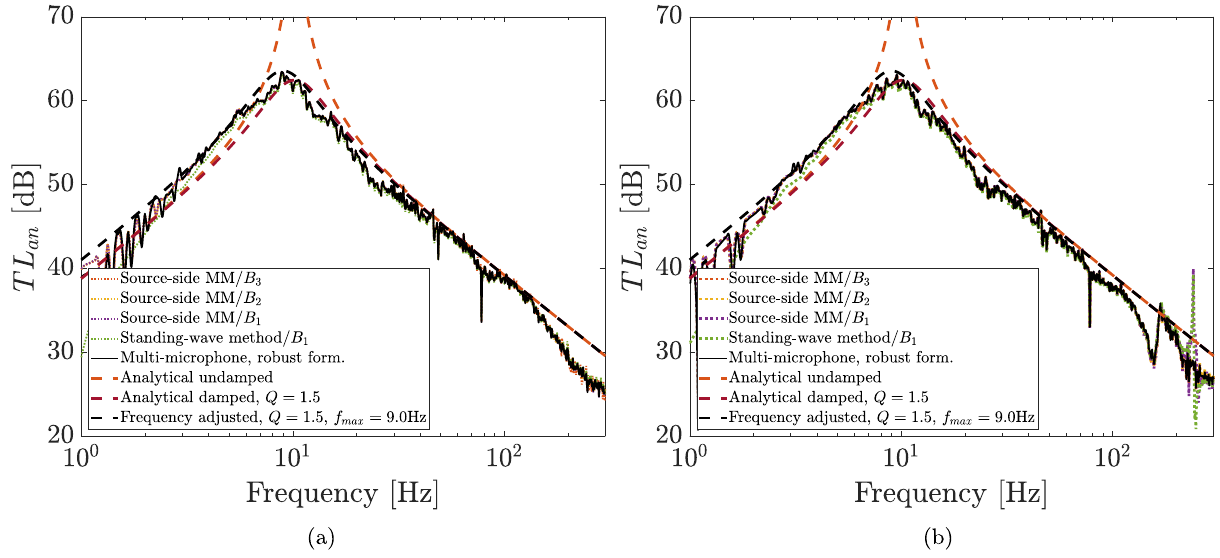
Figure 10. Comparison between measured TL an of the gas resonator with p 0 = 3.4 bar and p f = 5.5 bar for the 20 m PU tube termination (a) and the closed-end termination (b) using the source-side multi-microphone method with robust formulation, the standing-wave method and the classic multi-microphone method with robust formulation. The measured TL an are compared to undamped analytical model, damped model with quality factor Q = 1.5 and an frequency adjusted TL an plot with Q = 1.5 and f max = 9.0